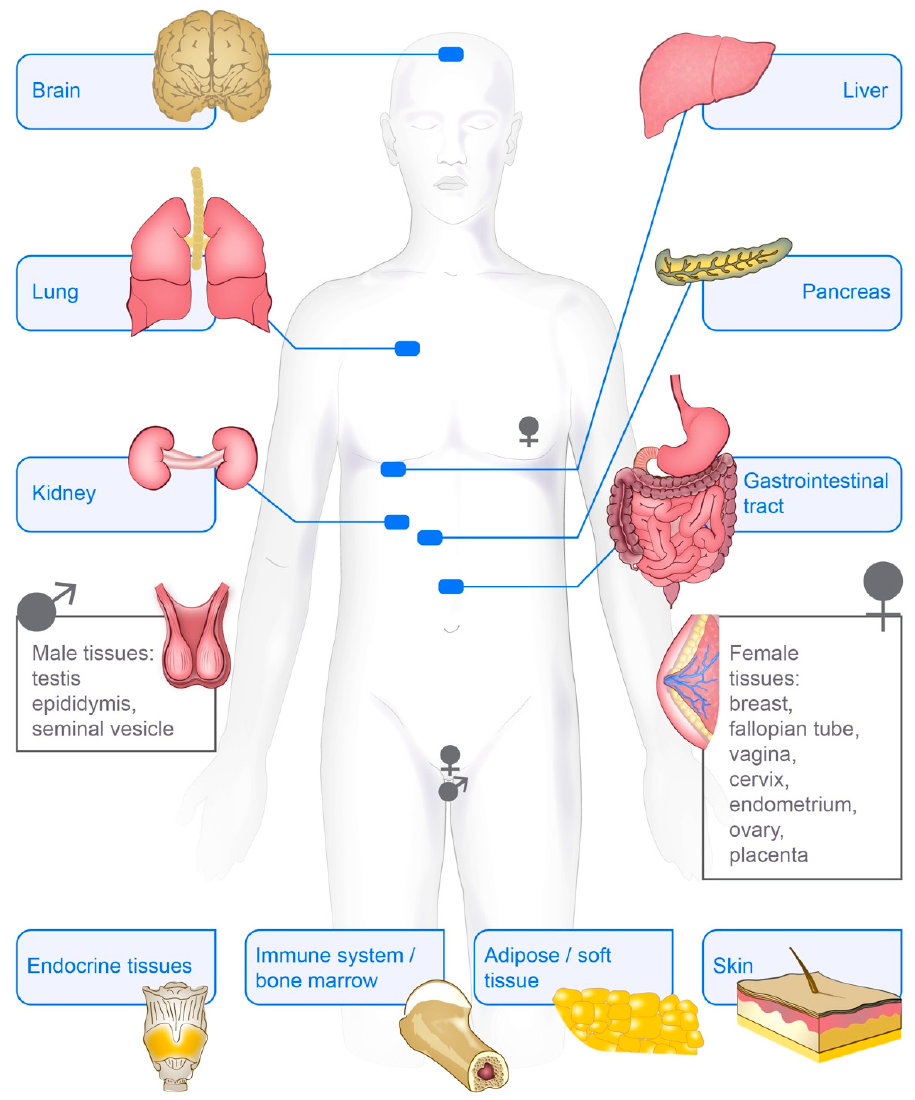
Figure 2. Example of tissue groups in which vimentin protein has been identified in low, medium or high levels. Gender-neutral and gender-specific tissue groups are indicated by blue or white squares, respectively.